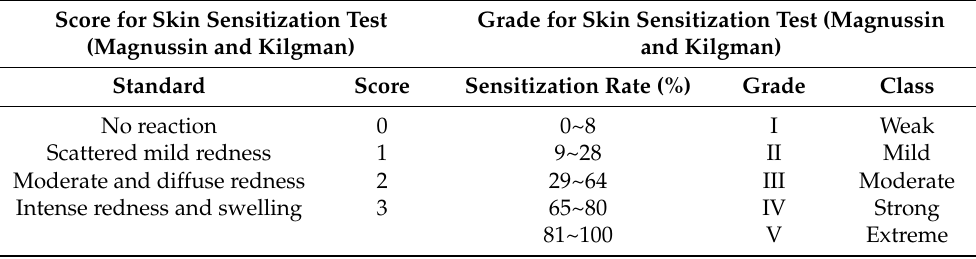
Table 1. Magnussin and Kilgman test, standard classes of Organization for Economic Co-operation and Development (OECD) guidelines for testing chemicals No.